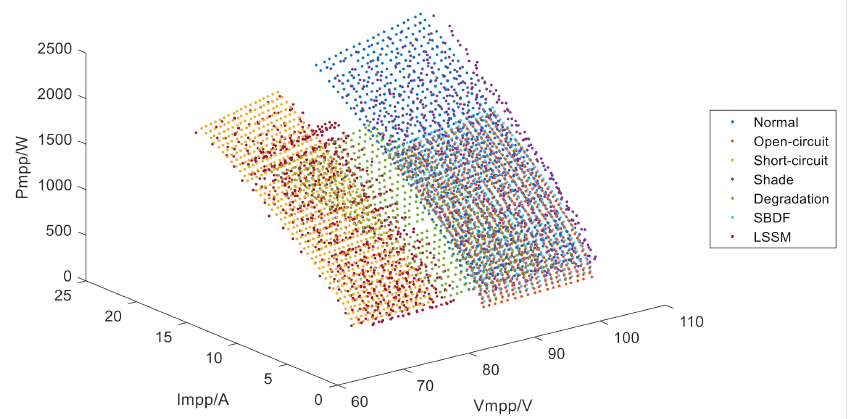
Figure 7. The MPP data of PV array under normal and fault